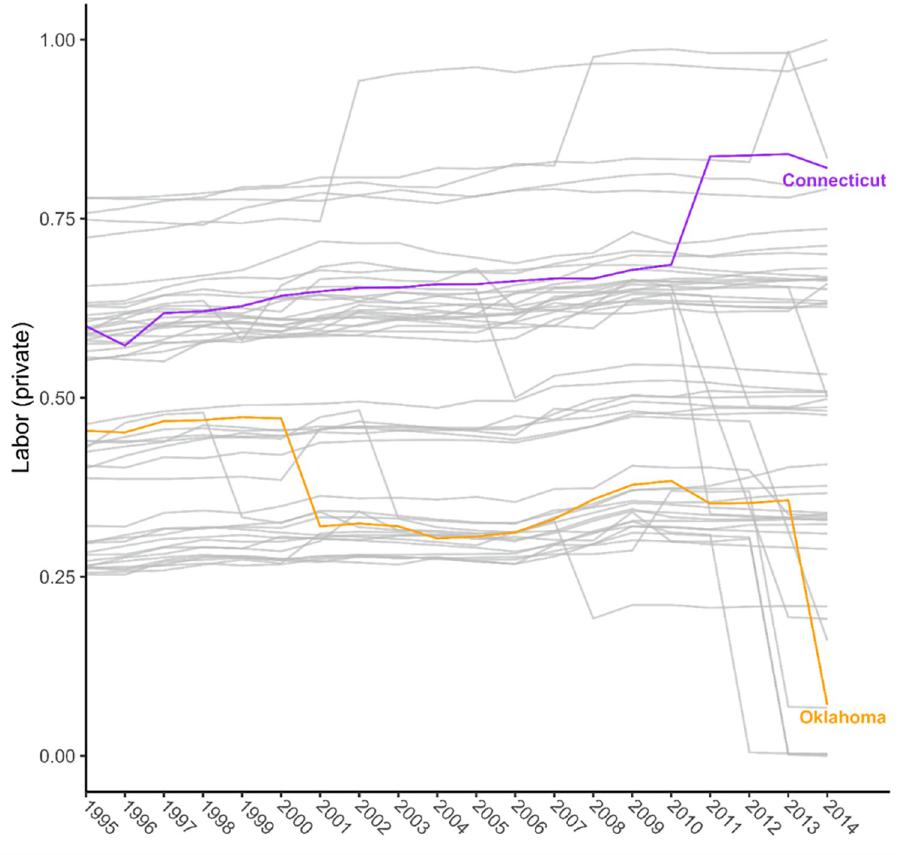
Fig 1. Trends in liberalism scores for private labor policies by U.S. State, 1995–2014. The figure contains a line for every state. Scores range from 0 to 1 on a conservative to liberal continuum.